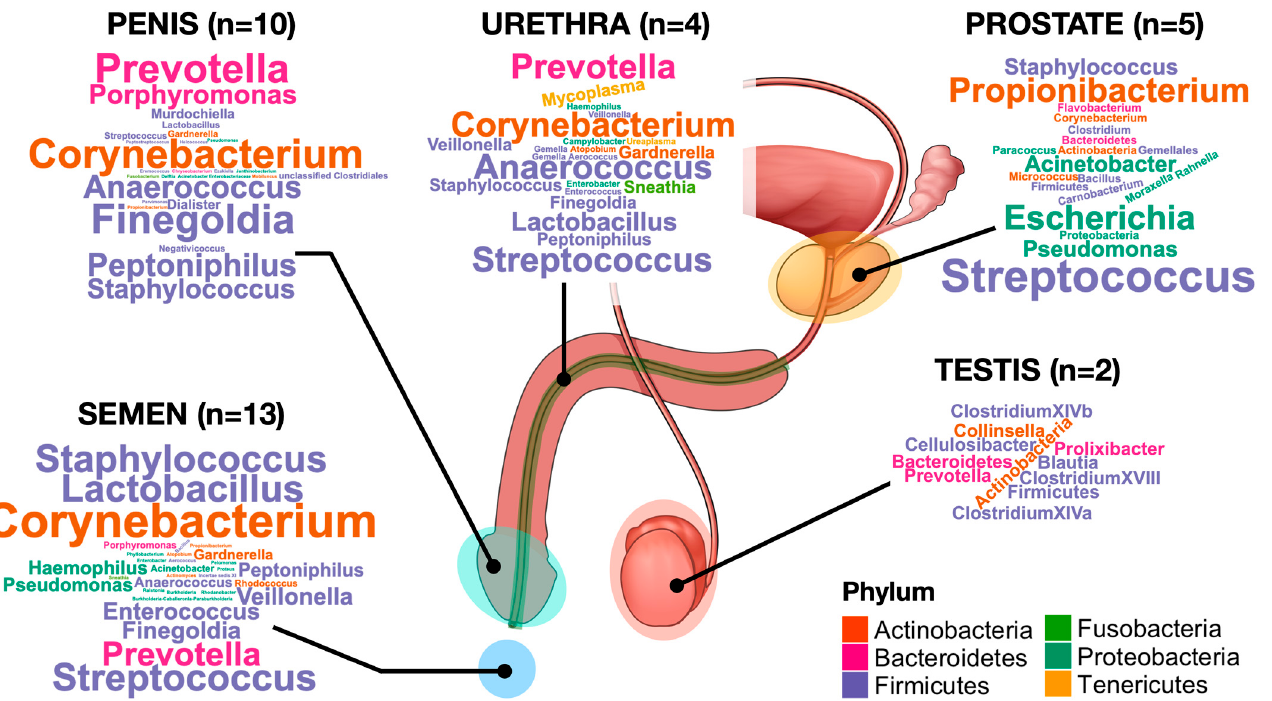
Figure 1. Word cloud representation of the major bacterial taxa identified in the MGT. The size of each taxon is proportional to its occurrence in all the NGS studies used to characterise the microbiota of specific parts of the MGT. The number of studies used to generate the graphs is indicated in brackets.